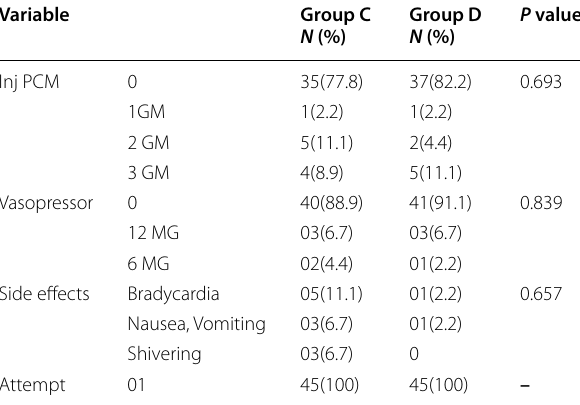
Statistically in significant ( p >